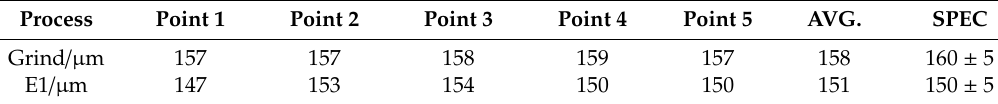
Table 4. The silicon thickness in Grind and E1 process.